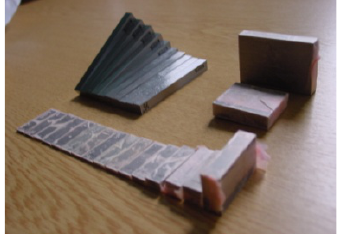
Figure 2. Inset plates with the calibrated tooling balls during the manufacturing process.